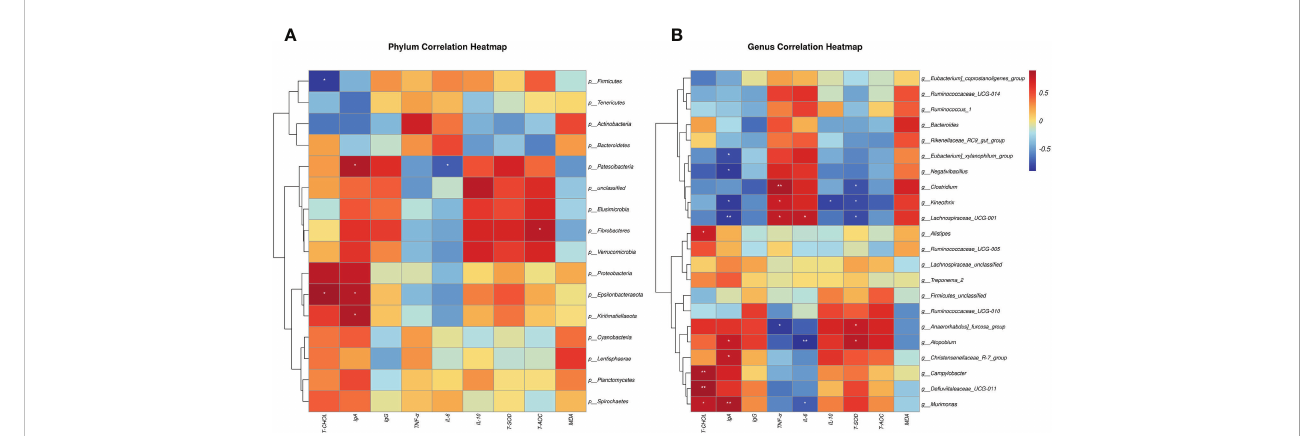
FIGURE 6 Spearman correlation between rectal microbiotas and differential plasma related indicators (0h). (A) Phylum correlation heatmap. (B) Genus correlation heatmap. Red denotes a positive correlation; blue denotes a negative correlation. The color intensity is proportional to the strength of the Spearman correlation. * P < 0.05 , ** P < 0.01